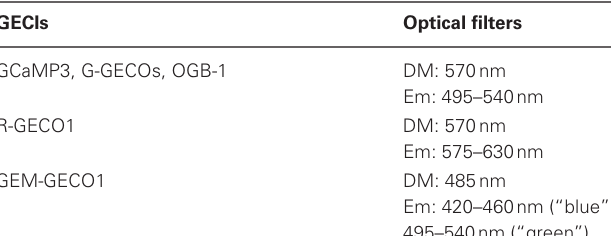
Table 1 | Summary of optical filters (all from